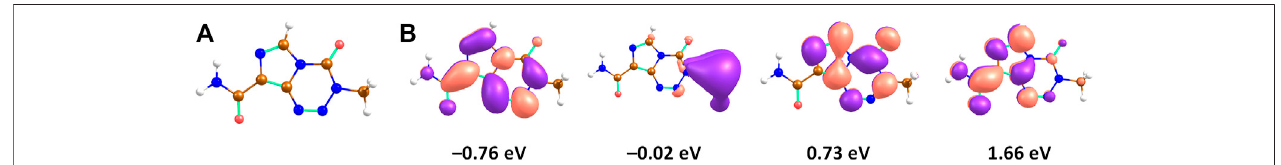
FIGURE 1 | (A) Structure of the TMZ molecule. (B) Orbitals occupied by a single electron in four TMZ – electronic states in the optimal structure of the neutral moleculealongwiththerelativeenergycomparedtotheneutralmolecule;calculatedattheCAM-B3LYP/aug-cc-pVDZ//B3LYP/aug-cc-pVDZleveloftheoryandshifted by the vertical electron af fi nity calculated at the CCSD/aug-cc-pVDZ level (0.76 eV). The orbitals were generated using natural transition orbitals analysis, the energy of the dipole-bound state was obtained using the aug-cc-pVDZ(C,N,O)TZ(H) + basis set, see Methods. Color code: brown – carbon, blue – nitrogen, red – oxygen, white – hydrogen.